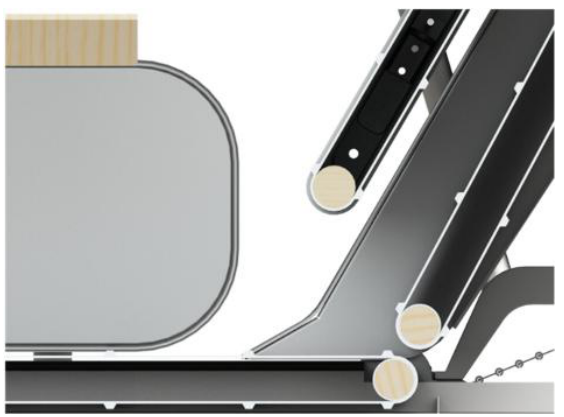
Figure 12. Sectional view of the passage of the conveyor belts.